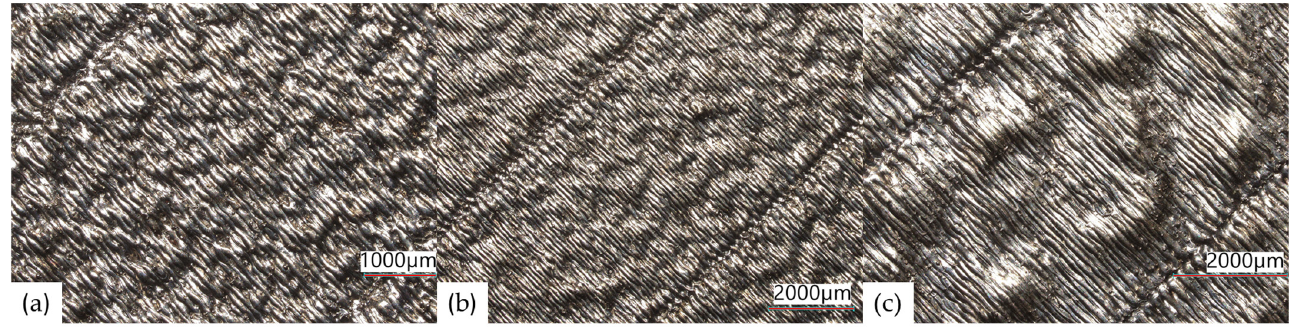
Figure 17. Effect of annealing on Rockwell hardness HRC on the side surface.